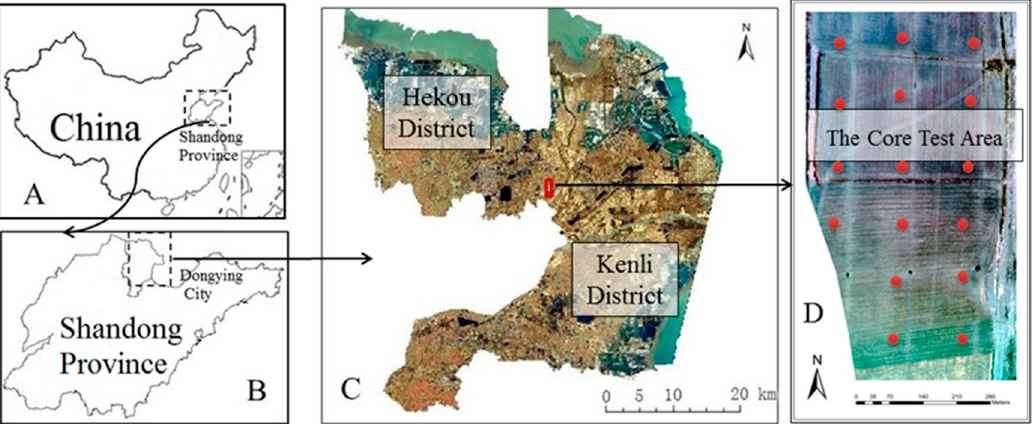
Figure 1. Location of the study area. (A: China; B: Shandong Province; C: the study area; D: part of the core test area, the red dots represent the sampling points).